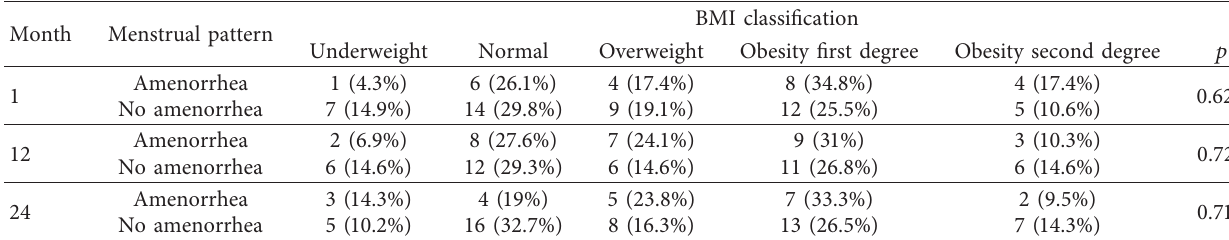
Table 6: The relationship between BMI and amenorrhea in one-rod users.